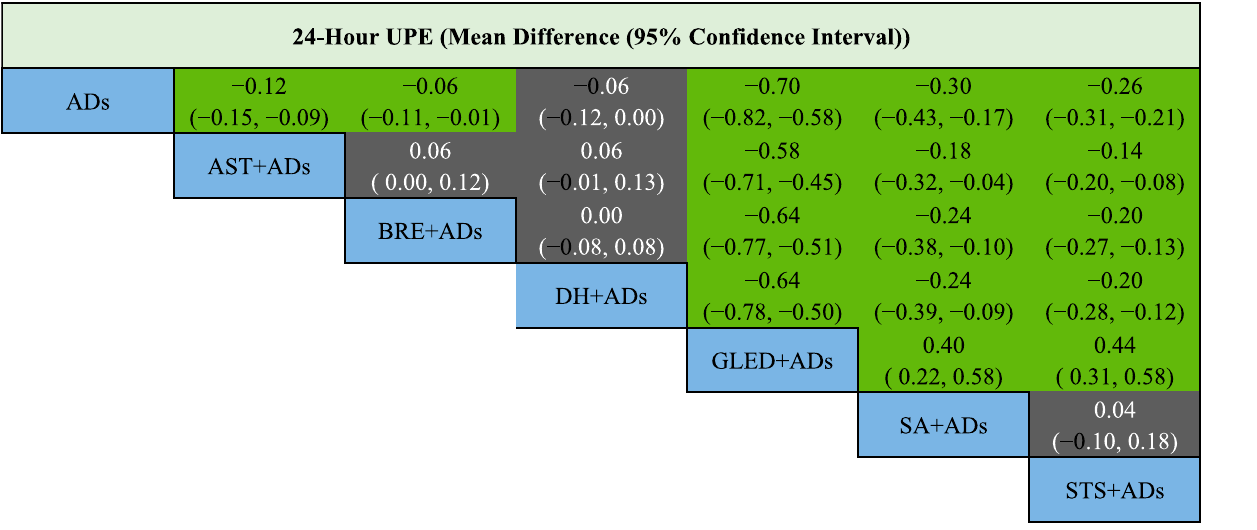
TABLE 1 | League table for 24-h UPE.